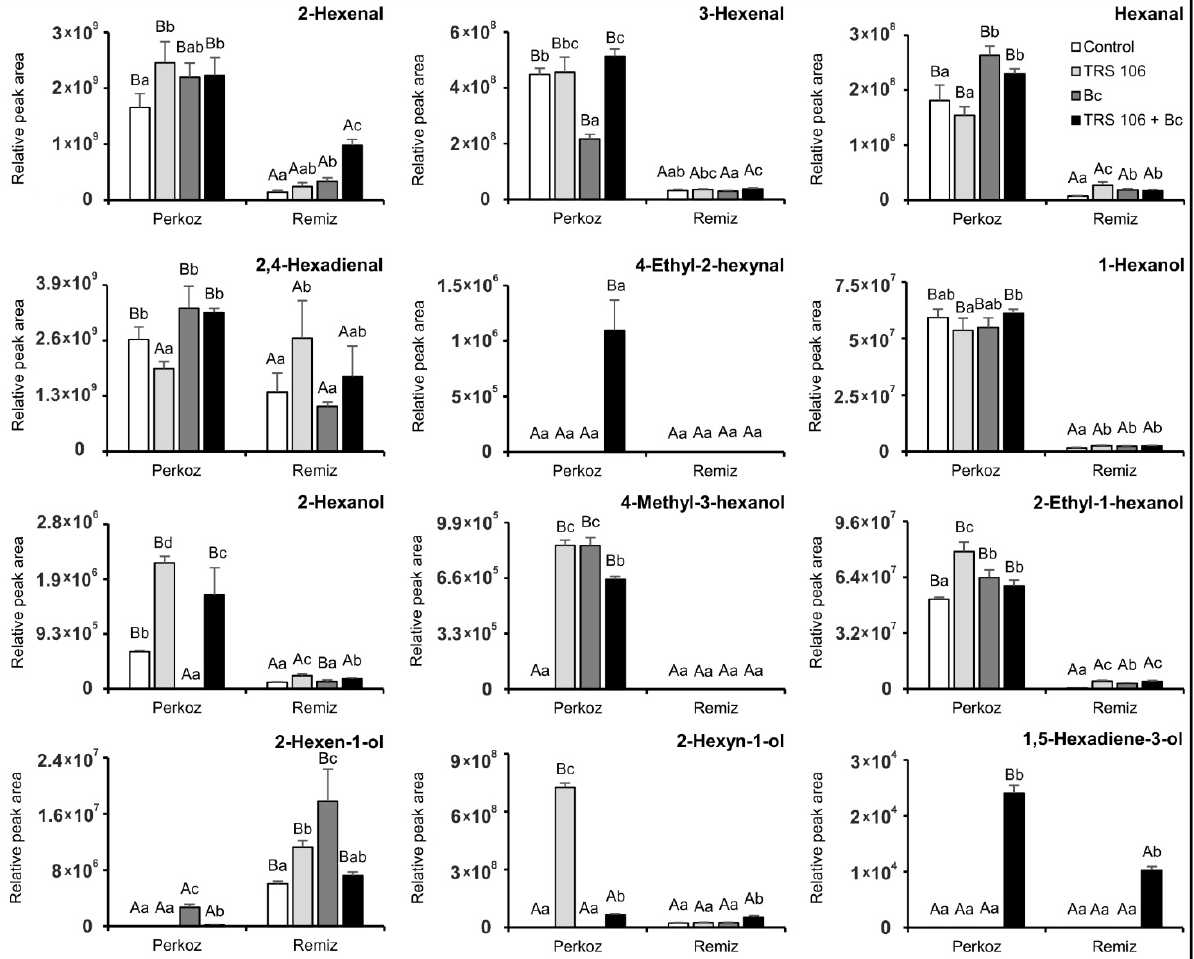
Figure 7. Effect of TRS 106 on green leaf volatiles (GLV) emission. Values represent the means + SE from five independent experiments (n = 5). Separately for each parameter, differences between varieties within a given variant were analyzed with Student’s t -test and marked using letters A and B. Separately for each variety, differences between all variants were analyzed with one-way ANOVA ( p < 0.05) with a Tukey multiple range post hoc test. Data points followed by a different letter are significantly different at p ≤ 0.05. Abbreviations are as in Figure